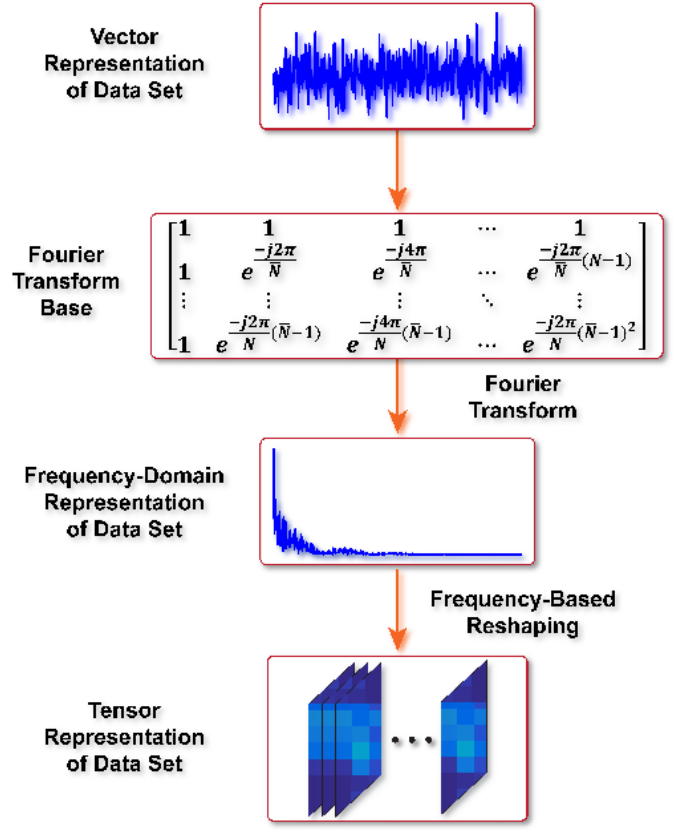
Figure 5. Reprocessing and reshaping of the experimental data.